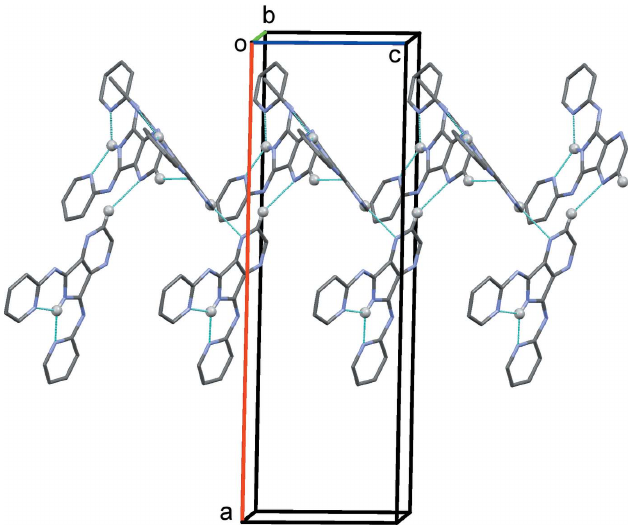
Figure 2 A partial view along the b axis of the crystal packing of the title compound. The intra- and intermolecular hydrogen bonds are shown as dashed lines (see Table 1; atoms H5 N and H2 are shown as grey balls).